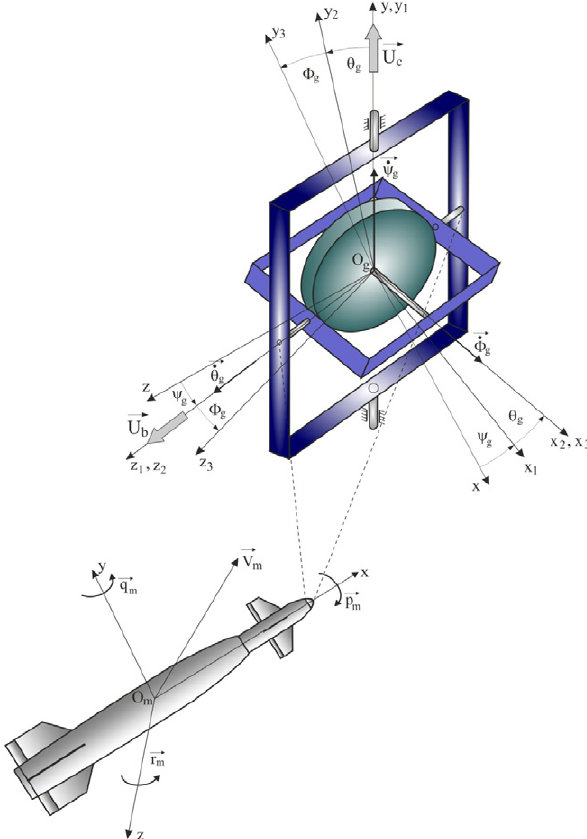
Figure 2. General view of a gyroscope system of a missile homing